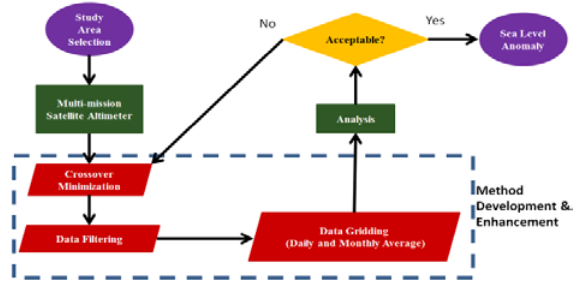
Figure 4. Overview of altimetry data processing in RADS (Din, 2014) Table 2. Corrections and models applied to RADS